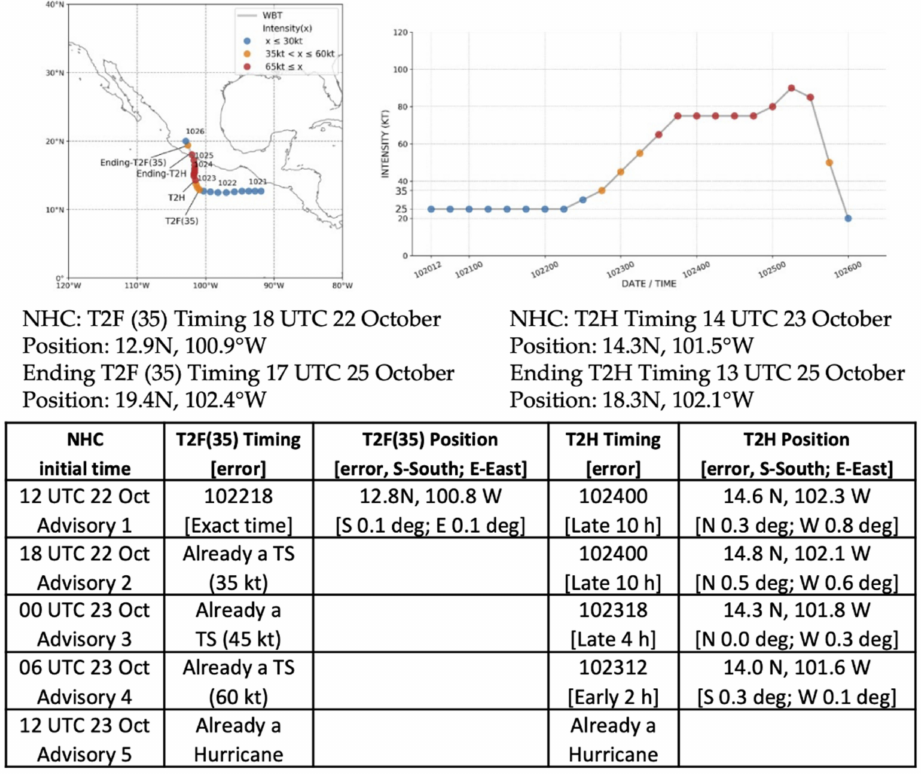
Figure 16. National Hurricane Center (NHC) forecasts of the T2F(35) and the T2H timing and positions based on NHC advisories as in Figure 4 except during